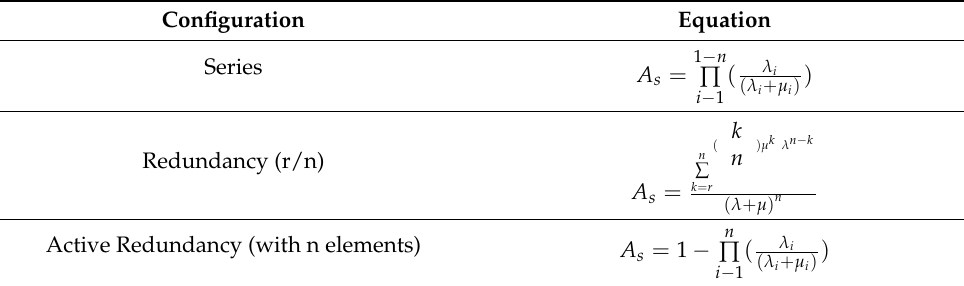
Table 1. Equations to estimate a system’s availability